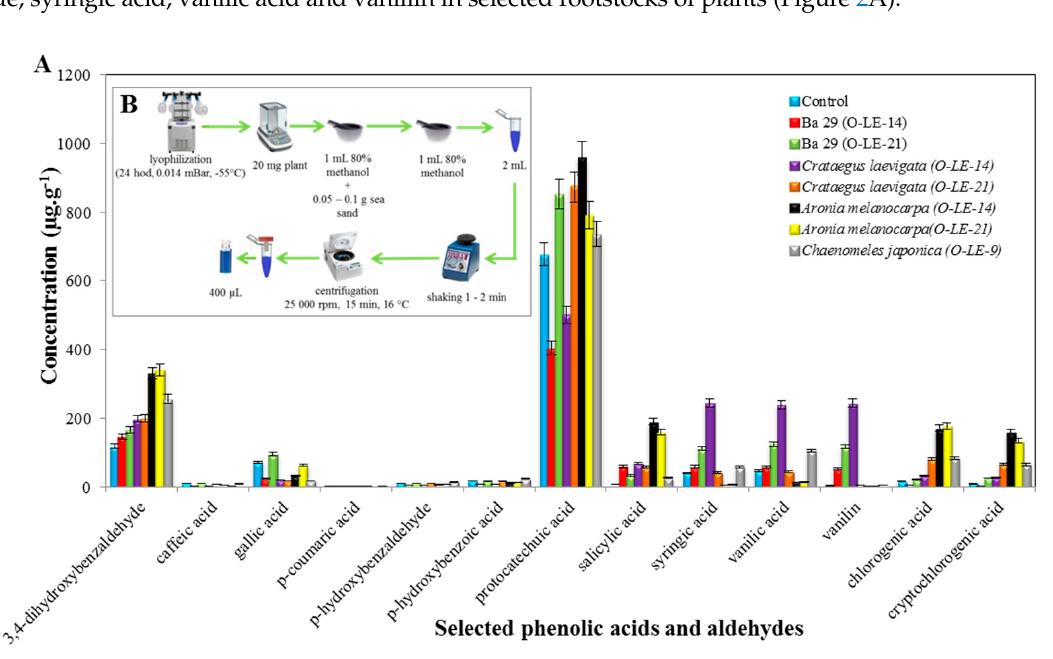
Figure 2. ( A ) Determination of the concentration of selected phenolic acids and aldehydes in the extract from the rootstocks of plants; ( B ) scheme of preparation of the sample for the LC/MS analysis.